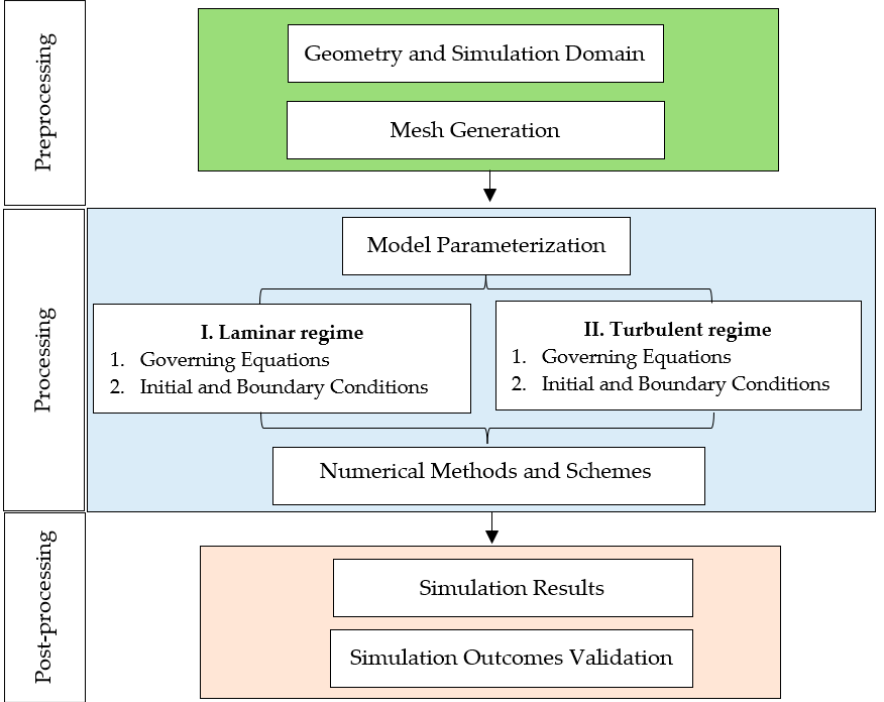
Figure 1. Flowchart of the numerical modeling